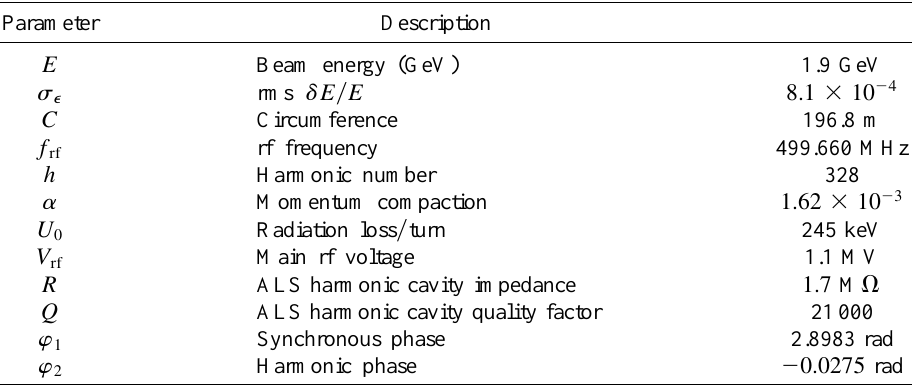
TABLE I. Nominal ALS parameters.